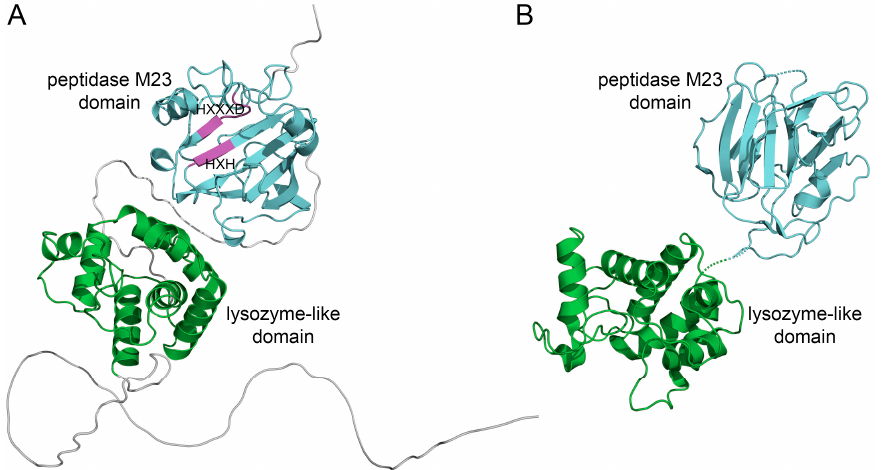
Figure 1. A. Model structure of BLF3872 obtained by using AlphaFold [46]. The N- and C-terminal domains are highlighted using green and cyan, respectively. Conservative motifs HXXXD and HXH in the peptidase M23 domain are marked using magenta. B . The 3D structure of Zn 2+ loaded Morphogenesis protein 1 from Bacillus phage phi29 (chain A of 3CSQ, X-RAY). The lysozyme-like domain and peptidase M23 domain are highlighted using green and cyan, respectively.